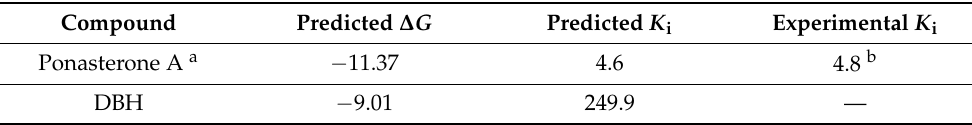
Table 1. Predicted free energies of binding ( Δ G , kcal/mol) and inhibition constant ( K i , nM) for the EcR receptor.